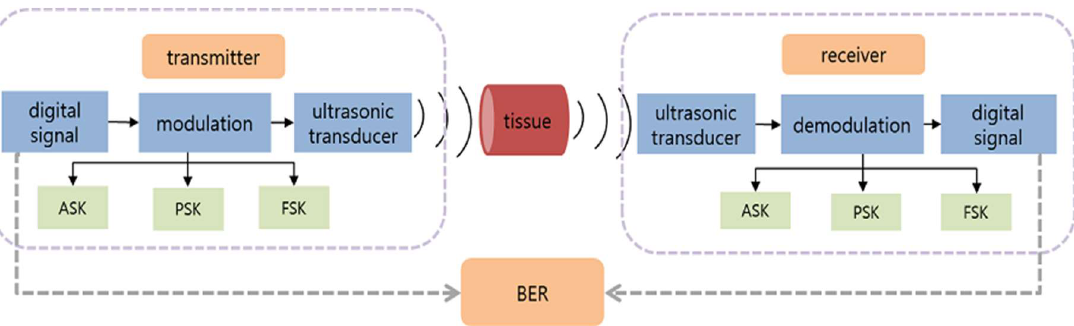
Figure 2. Architecture of ultrasonic communication for body sensor networks.